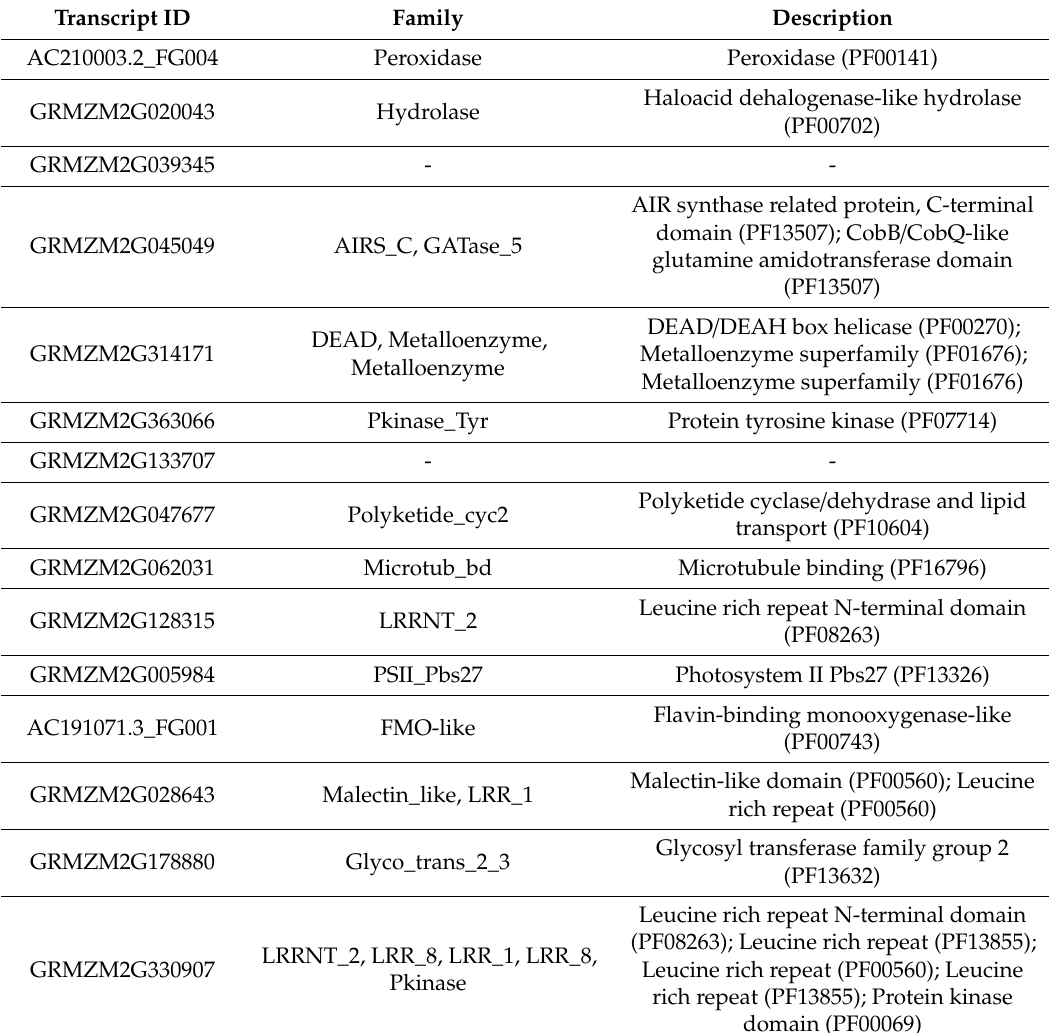
Table 6. Pfam (EBI 2019) Domain Analysis of the 15 Upregulated Genes via